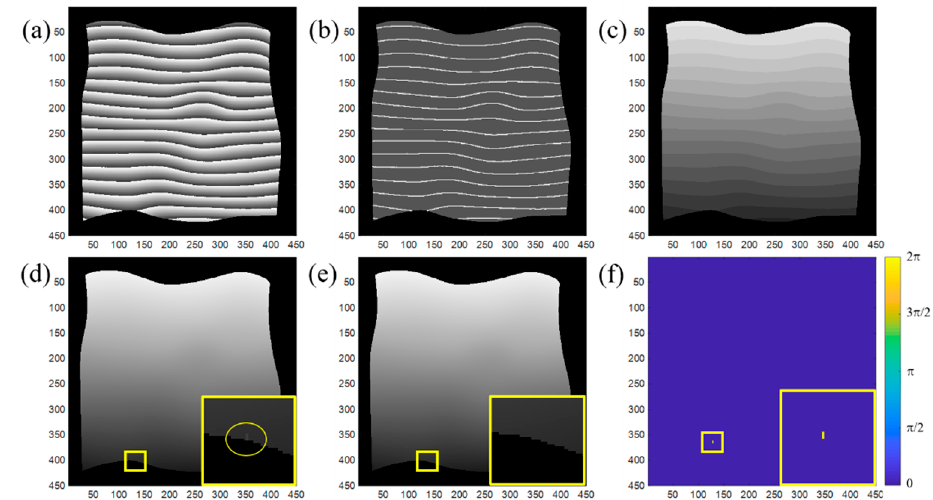
Figure 5. Phase unwrapping and 3D reconstruction. ( a ) Input data, ( b ) output phase feature map from network I, ( c ) phase feature map with assigned integer to each segment from network II, ( d ) unwrapped phase using the proposed method, ( e ) unwrapped phase using floodfill phase unwrapping method, and ( f ) difference between ( d ) and ( e ).